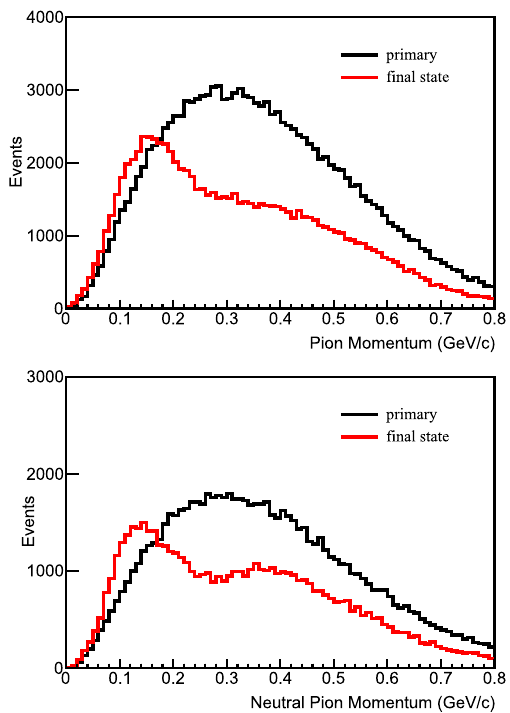
Fig. 34 Top:momentumofanindividualchargedpionbeforeandafter finalstateinteractions.Bottom:momentumofanindividualneutralpion before and after final state interactions